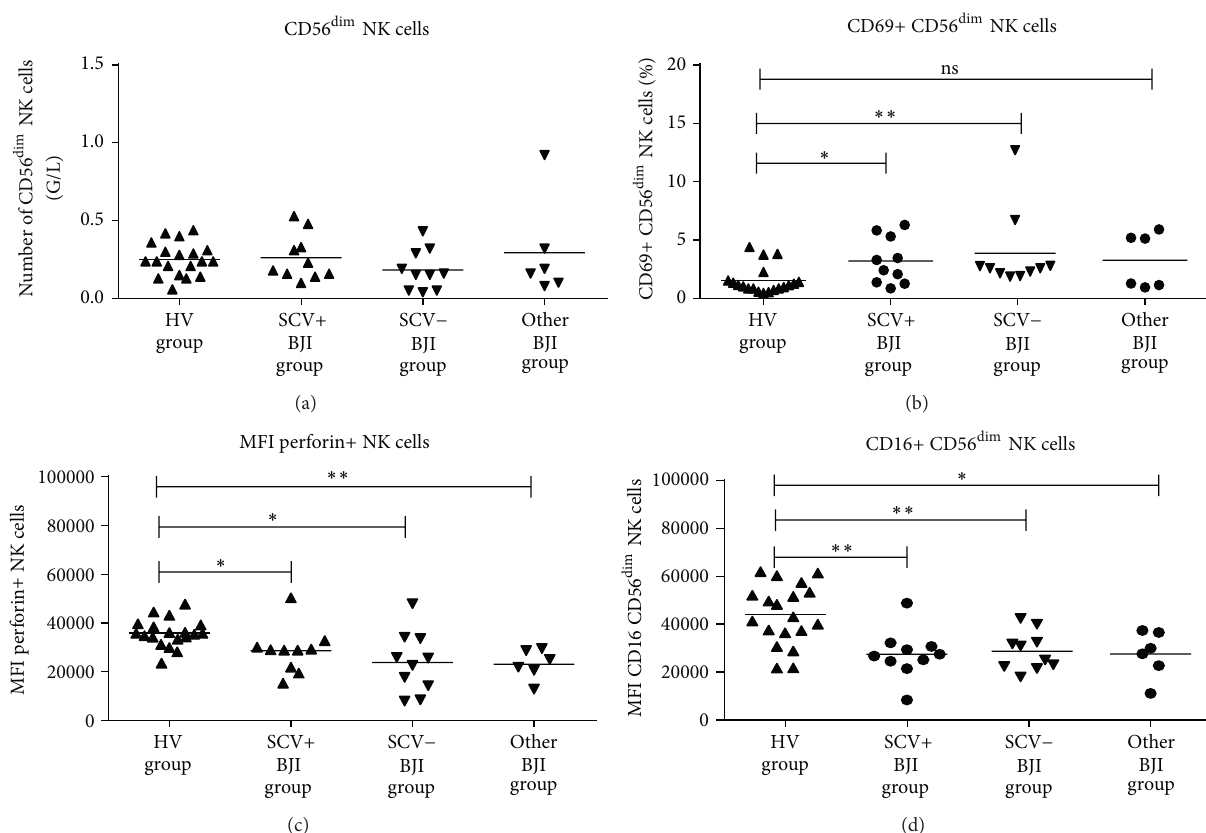
Figure 1: Absolute number of circulating NK cells (a) and their expression of CD69, CD16, and perforin ((b), (c), and (d), resp.) in each group of patients ( ∗ 𝑃 < 0.05 ; ∗∗ 𝑃 < 0.001